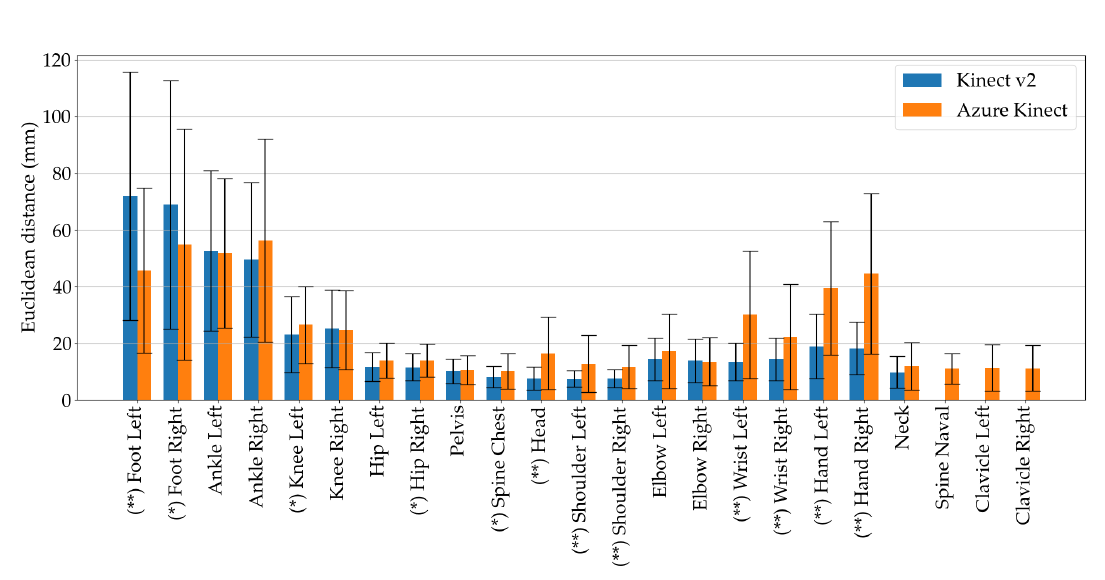
Figure A1. Spatial agreement between Microsoft Kinect v2 and Azure Kinect for 3.0 kmh − 1